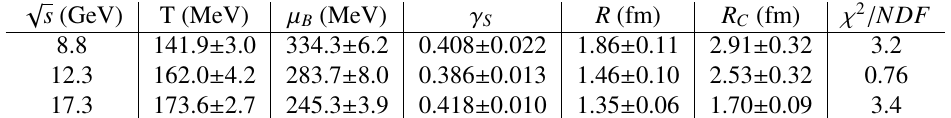
Table 2. Values of best fits of SC statistical model to the experimental yields of hadrons from p + p collision at 3 collision energies (see text for